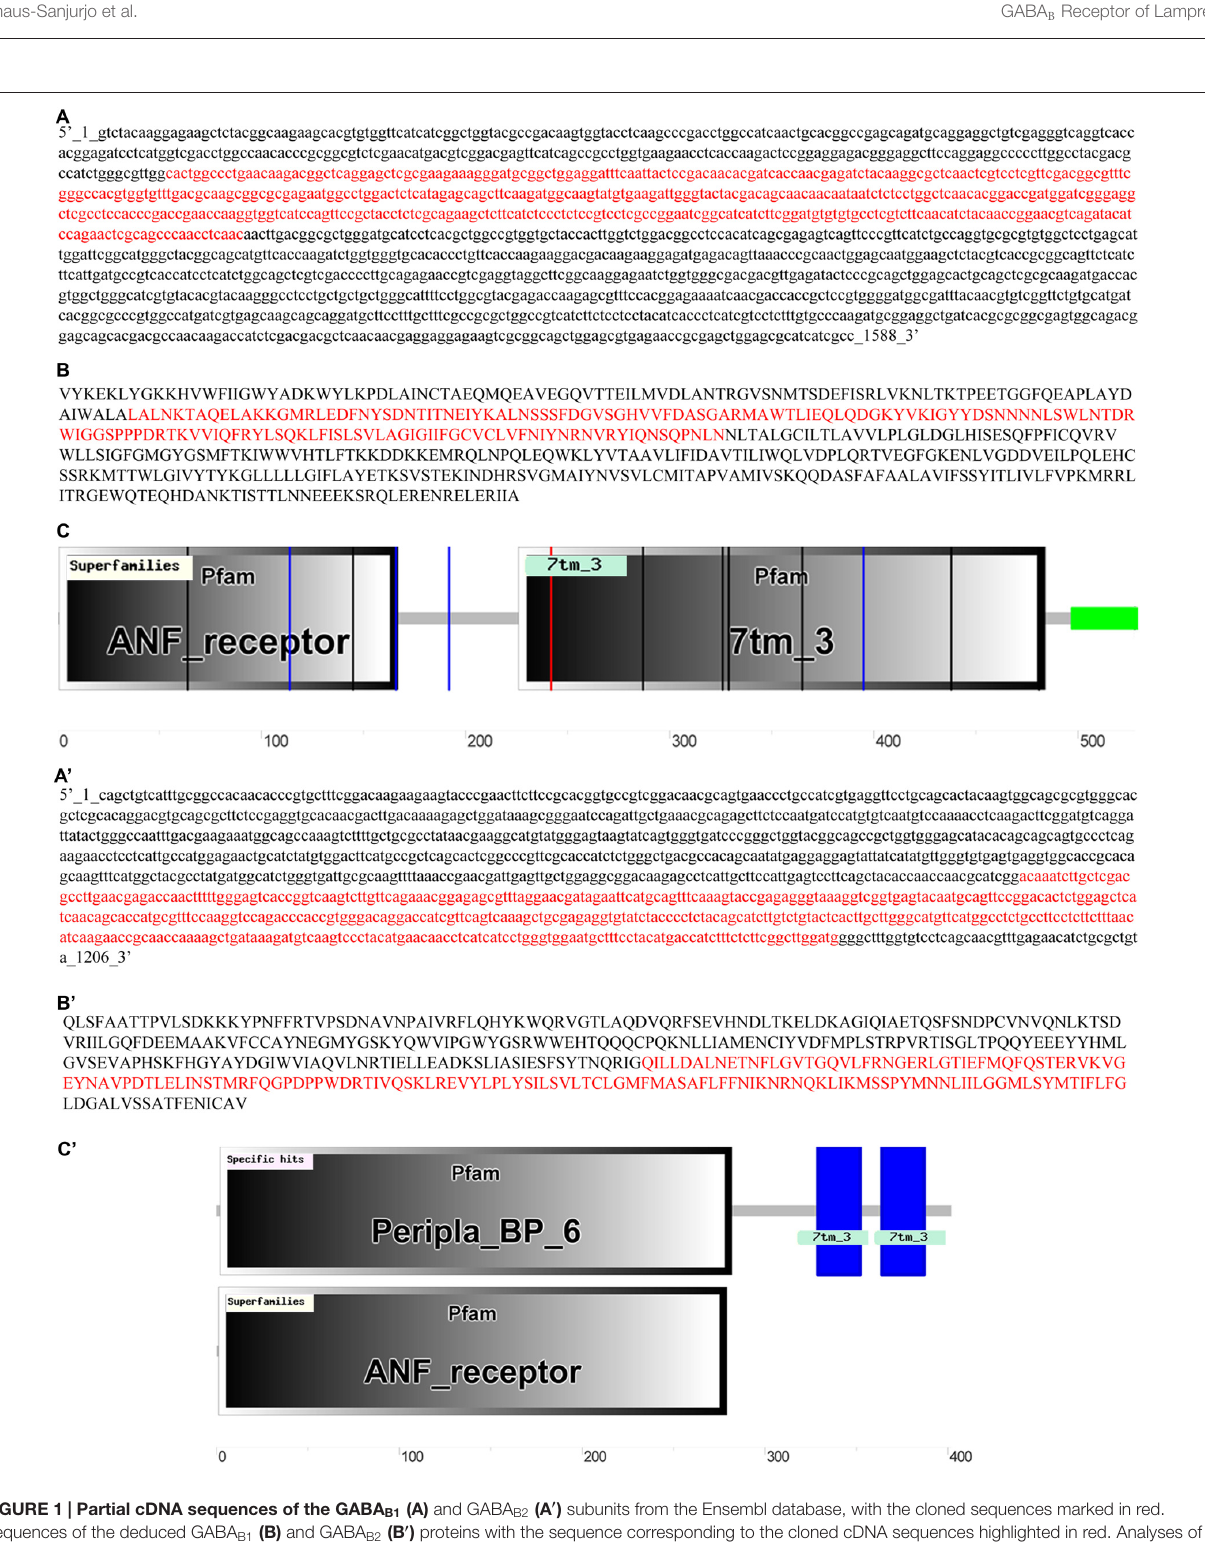
and photographed with an Olympus photomicroscope (AX-70; Provis) equipped with a color digital camera (Olympus DP70; Tokyo, Japan). Images were slightly adjusted for